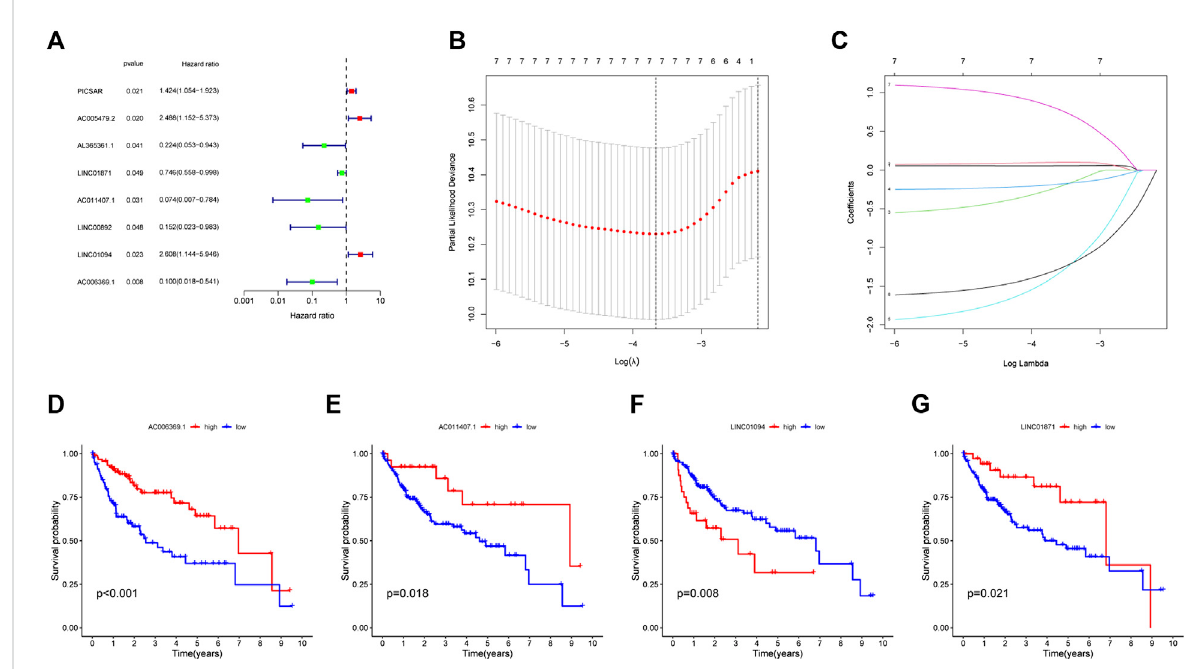
FIGURE 3 Selection of IIRLs and KM survival curves for the four prognostic IIRLs. (A) Univariate Cox regression showing eight IIRLs were associated with HCC prognosis. (B – C) Lasso regression con fi rmed seven IIRLs. (D – G) LINC01871, AC011407.1, and AC006369.1 were independent protective factors for HCC, while LINC01094 was an independent risk factor for HCC.